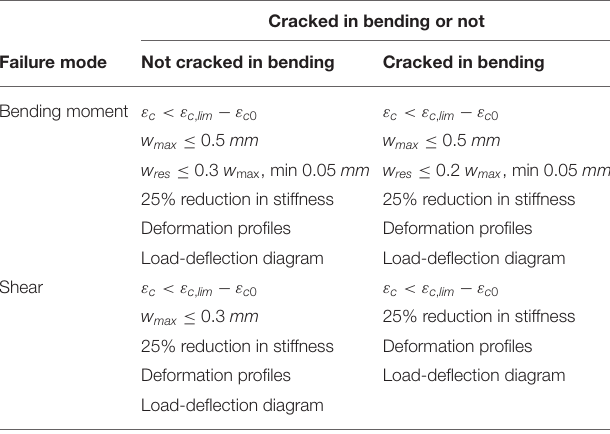
TABLE 1 | Recommendations for stop criteria for proof load testing (Lantsoght et al.,